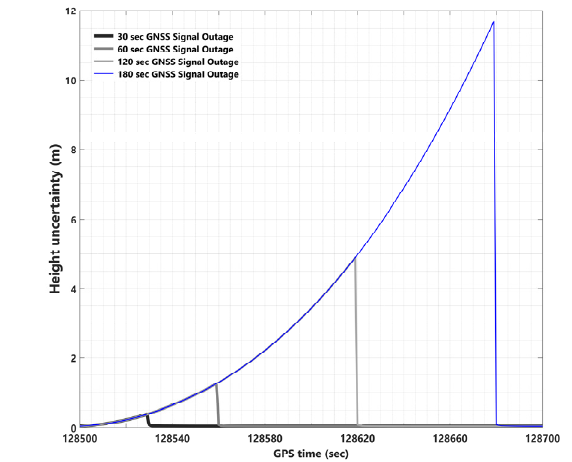
Figure 5. Height uncertainties using forward KF processing and assuming different GNSS outage durations.